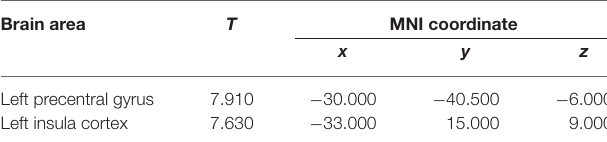
Gray matter atrophy was found in the left precentral gyrus and insula cortex of patients with OPVHs in a multivariate regression analysis (p < 0.05, FWE-corrected, with 30-voxel clustering